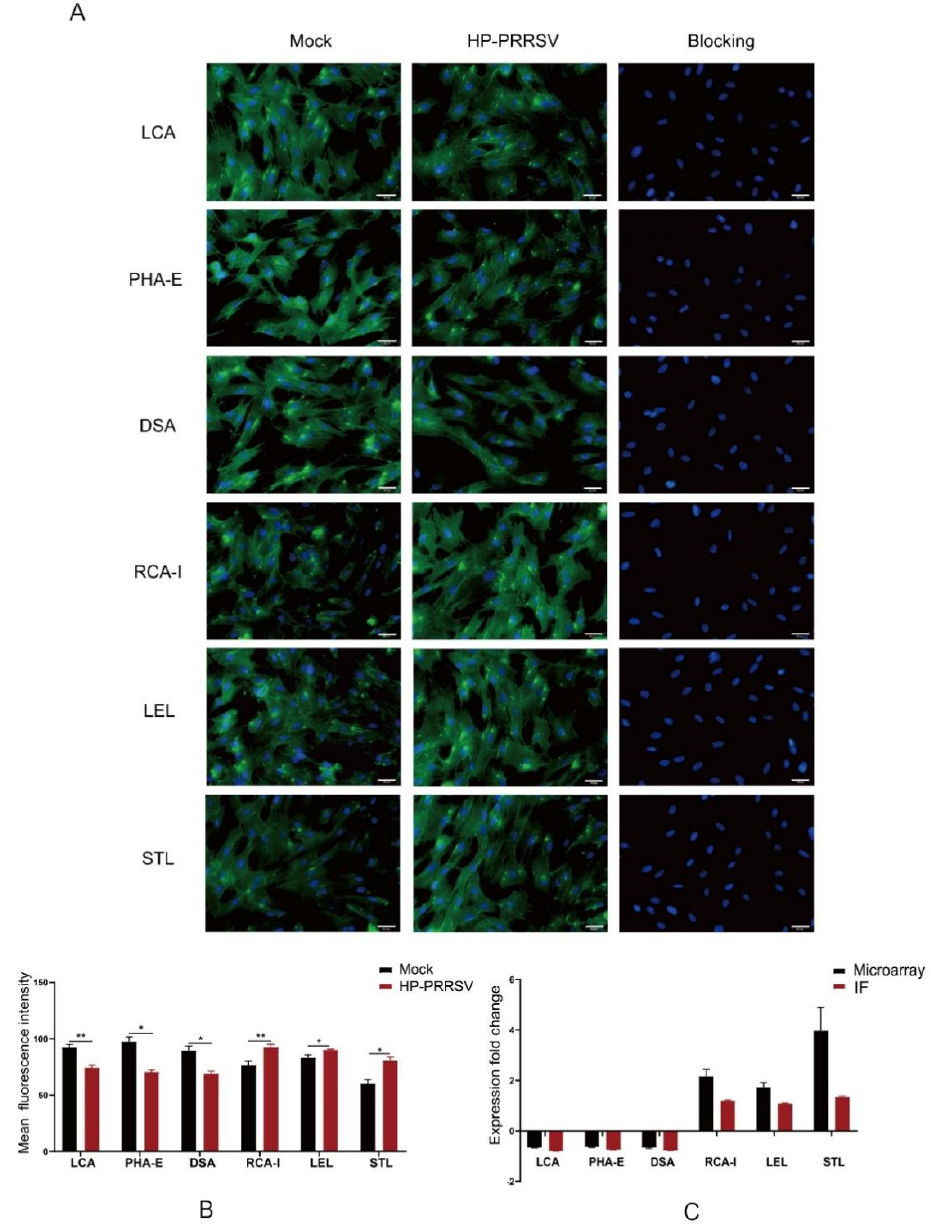
Figure 7. Lectin fluorescence staining of HP-PRRSV HN infected PPMVECs. Bar = 20 µ m. ( A ) Photographs of lectin fluorescence staining. ( B ) Mean intensities of lectin fluorescence staining. ( C ) Comparison of the fold change in - fluorescence intensities between lectin microarrays and lectin fluorescence staining (IF). Statistical analysis was performed by Student’s t -test. * p < 0.05; ** p < 0.01.